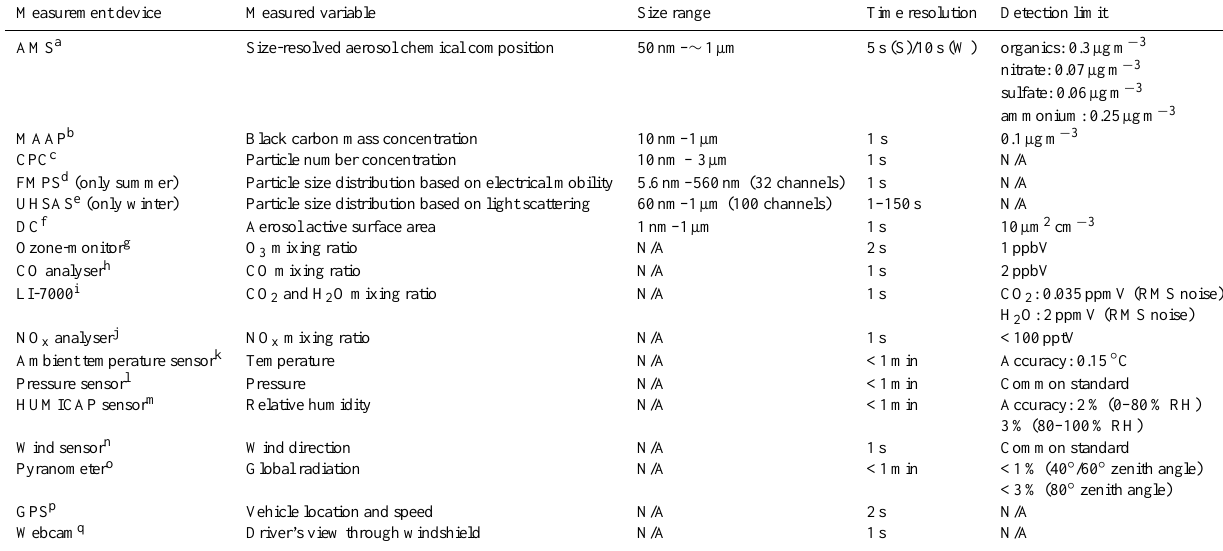
Table 2. Summary of measurement devices – including information about measured variables, size range, time resolution and detection limit – installed in the mobile laboratory MOSQUITA (Paul Scherrer Institute) during the summer and winter MEGAPOLI field campaigns. AMS detection limits were calculated and averaged for the two mobile measurements presented in this work (S=summer,